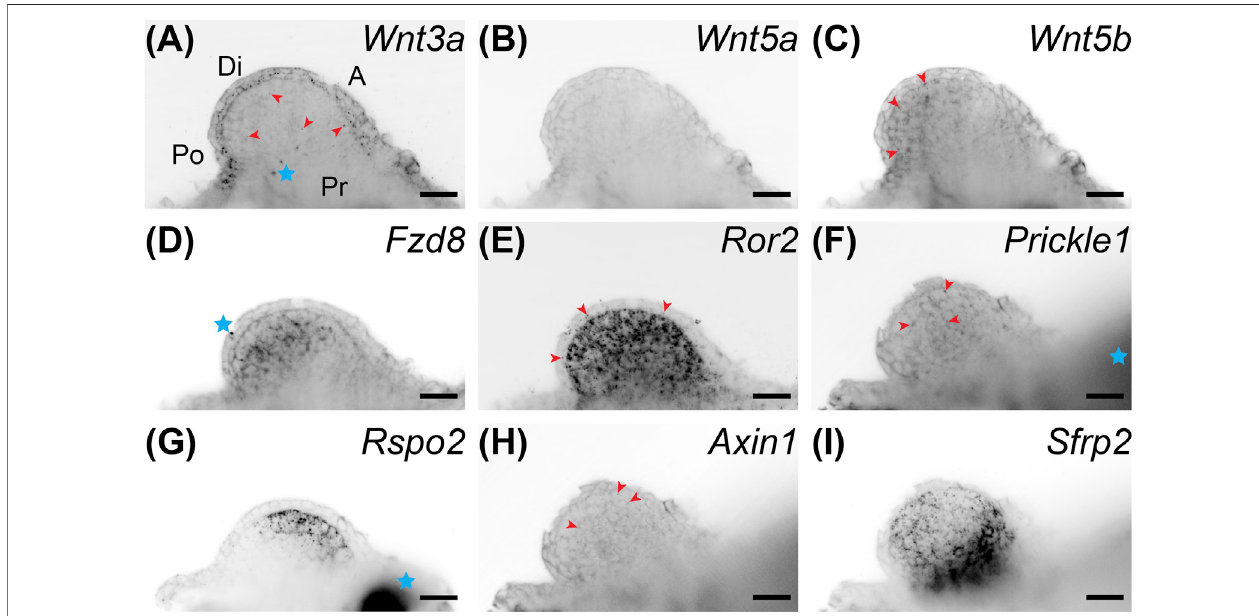
FIGURE 3 | Coronal single z-plane images of whole mount HCR-FISH of Wnt signaling genes after 5 μ M C59 treatment. Limbs were treated starting at stage 42 and collected on day 6 of treatment. (A) Wnt3a expression after C59 treatment. The pattern of expression is the same as untreated limbs ( Figure 1A ), but less pronounced. Red arrowheads show some staining in the mesenchyme although most staining is in the epithelium. The blue star indicates two non-speci fi c dots. Po is posterior, D is distal, A isanterior, and Pr is proximal. (B) Wnt5a expression is essentially absent after C59 treatment. (C) Wnt5b isstill lowly expressed in the same mesenchymal pattern as untreated limbs with minor staining in the epithelium ( Figure 1C ). (D) Fzd8 shows decreased staining after treatment, but the same pattern of expression inthemesenchymewithlittleintheepithelium.Thebluestarindicatesanon-speci fi csignalontheoutsidetheofthelimb. (E) Ror2 showedstrongexpression after C59 treatment with most expression in the mesenchyme and some in the epithelium, highlighted with red arrowheads. (F) Prickle1 lost most expression after C59 treatment, only retaining some expression in the mesenchyme, highlighted with red arrowheads. (G) Rspo2 switched from posterior expression to an anterior mesenchymal expression domain after C59 treatment. The blue star indicates auto fl uorescent muscle. (H) Axin1expression was minimal in limb buds treated with C59. The few positive signals are highlighted with red arrowheads. (I) Sfrp2 continued strong expression after C59 treatment. Scale bars in all panels are 50 µm.